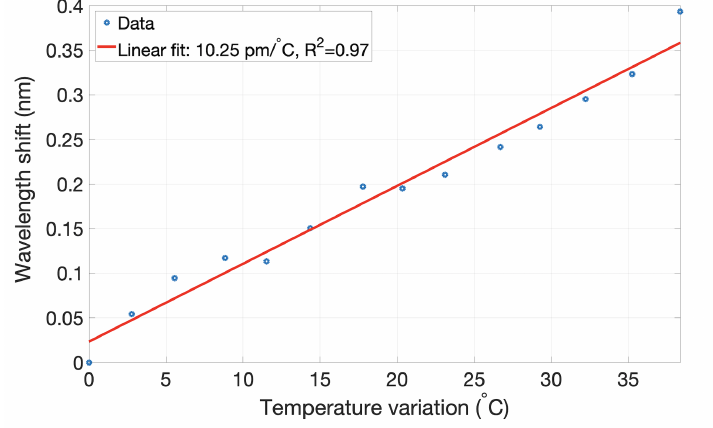
Figure 2. Wavelength shift recorded by the setup of twelve MgO-doped fibers with respect to temperature